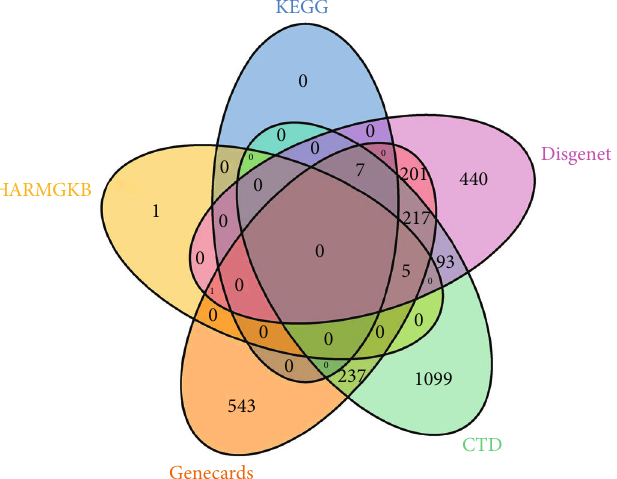
Figure 2: Five potential cervical cancer targets in